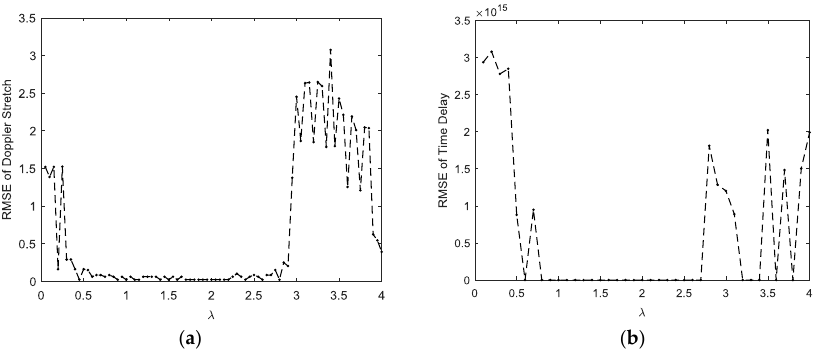
Figure 7. Estimation accuracy with respect to λ . ( a ) RMSE of the Doppler stretch; ( b ) RMSE of the time delay.